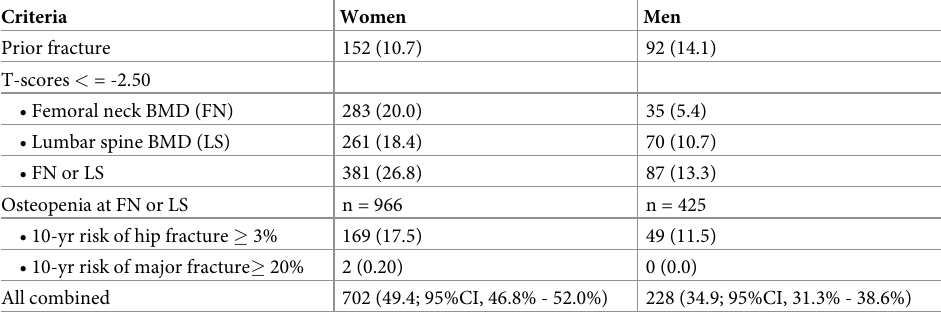
Table 3. Estimated number of Vietnamese individuals aged 50+ years who are eligible for treatment by the US National Osteoporosis Foundation Guidelines.